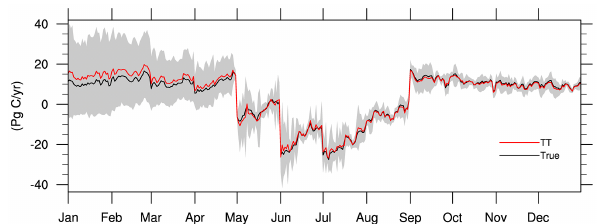
Figure 5. Time series of the posterior uncertainties (shaded areas) of the analyzed surface fluxes (TT) from 1 January to 31 December 2010.